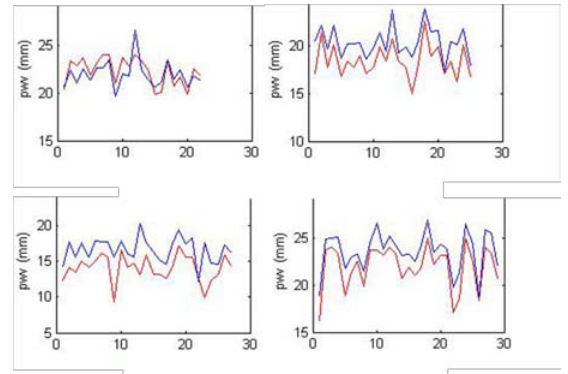
Figure4. comparison of MERIS PWV and GPS PWV of single day for 2015/6/8, 2015/6/14, 2015/6/18, 2015/10/1